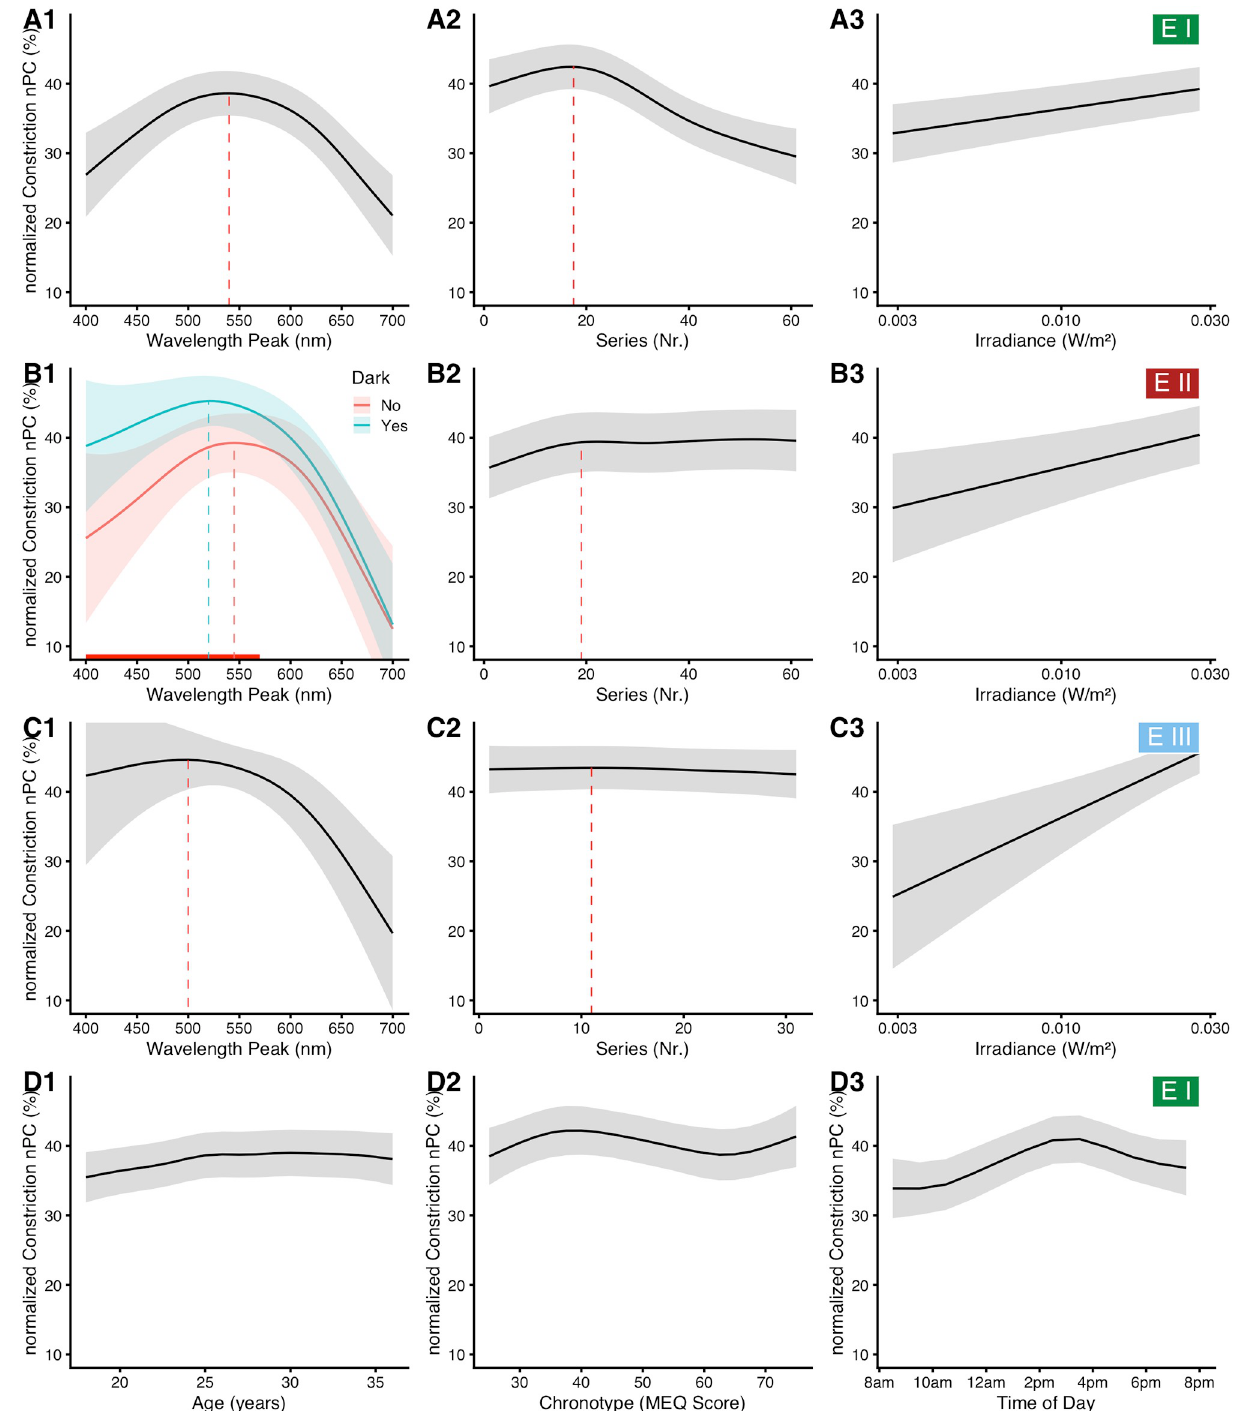
Fig 5. Model predictions. Model predictions for normalized pupillary constriction (nPC) as depending on several main predictors, when all other predictors are held at an average, constant level. Traces show the model prediction for the mean, ribbons its 95% confidence interval. Dotted lines show a peak that is discussed in the main text. In (A3, B3, and C3), the x-axis is logarithmically scaled to reflect the logarithmic transformation of irradiance in the model. (A) and (D) show dependencies in Experiment I , discussed here, (B) and (C) dependencies in Experiment II and III, respectively, discussed later. (B) The red line at the bottom of (B1) indicates where the two curves differ significantly at the 0.05 level of significance.